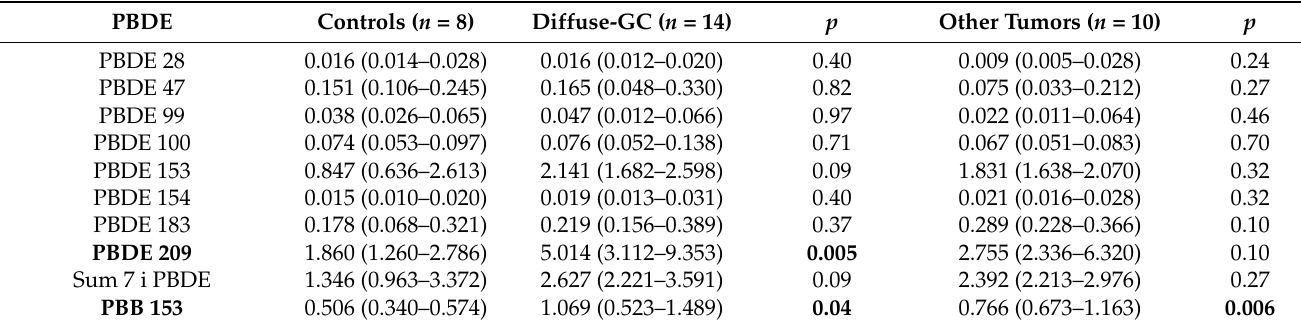
Table 4. Summary of polybromodiphenylethers (PBDE) and polybromobiphenyls (PBB) distributions and detection frequencies (DF) measured in omental fat from cases of diffuse-gastric cancer, other cancers with peritoneal metastasis, and non-cancer as control patients. Results were represented by median (ng/g lipid (interquartile range). The case groups were compared to the control group with Mann–Whitney U test ( p < 0.05).